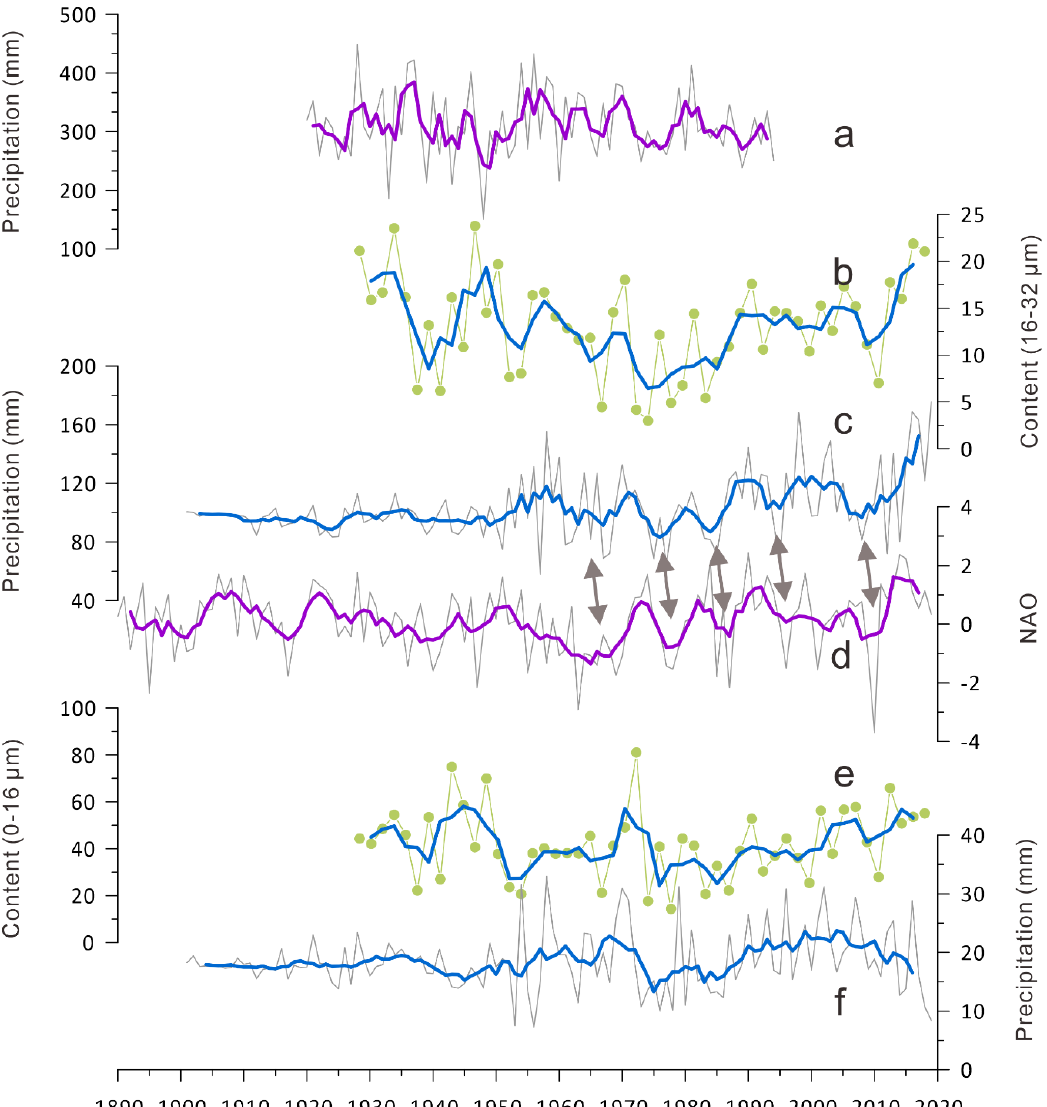
Figure 6. Comparisons of regional climate change. ( a ) Total precipitation from April to September at the meteorological station (Chonkyzylsu, 42.20° N 78.19° E, 1883–1996) located in the western Tian Shan [86]. ( b ) The three-point moving average curve of silty fraction content of 16 to 32 μm. ( c ) Total precipitation from April to September from cru_ts_4.04 grid-box data for 42.25° N, 83.25° E in the region of Lake Ta-Lung-Chi [22]. ( d ) The monthly North Atlantic Oscillation Index (station-based, December, January, and February) [81,82]. ( e ) The total content of clay and fine-silty fraction (0–16 μm). ( f ) The monthly precipitation in July from CRU TS 4.04 grid-box data for 42.25° N, 83.25° E in the region of Lake Ta-Lung-Chi [22].